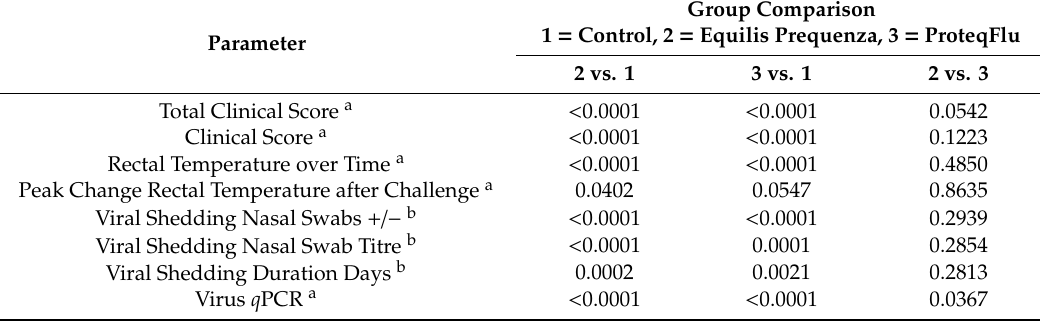
Table 4. Inferential statistics: Comparison of the clinical observations, rectal temperature and viral shedding after challenge between groups (mean e ff ect between 1 and 14 dpc a or 1 and 8 dpc b ). Group Comparison Parameter